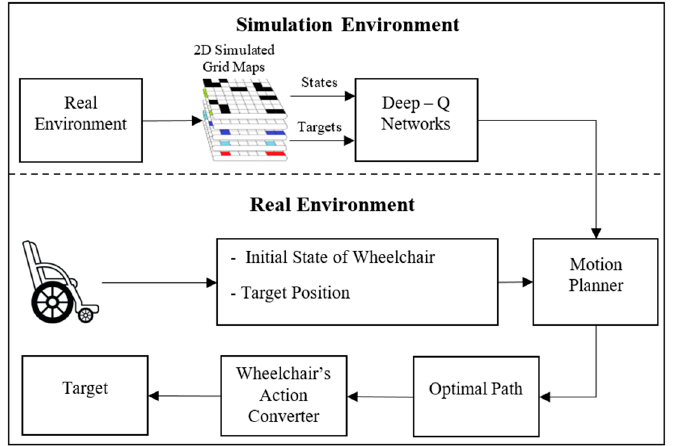
Figure 1. Representation of the system architecture for finding the optimal path of the wheelchair based on the 2D grid map.